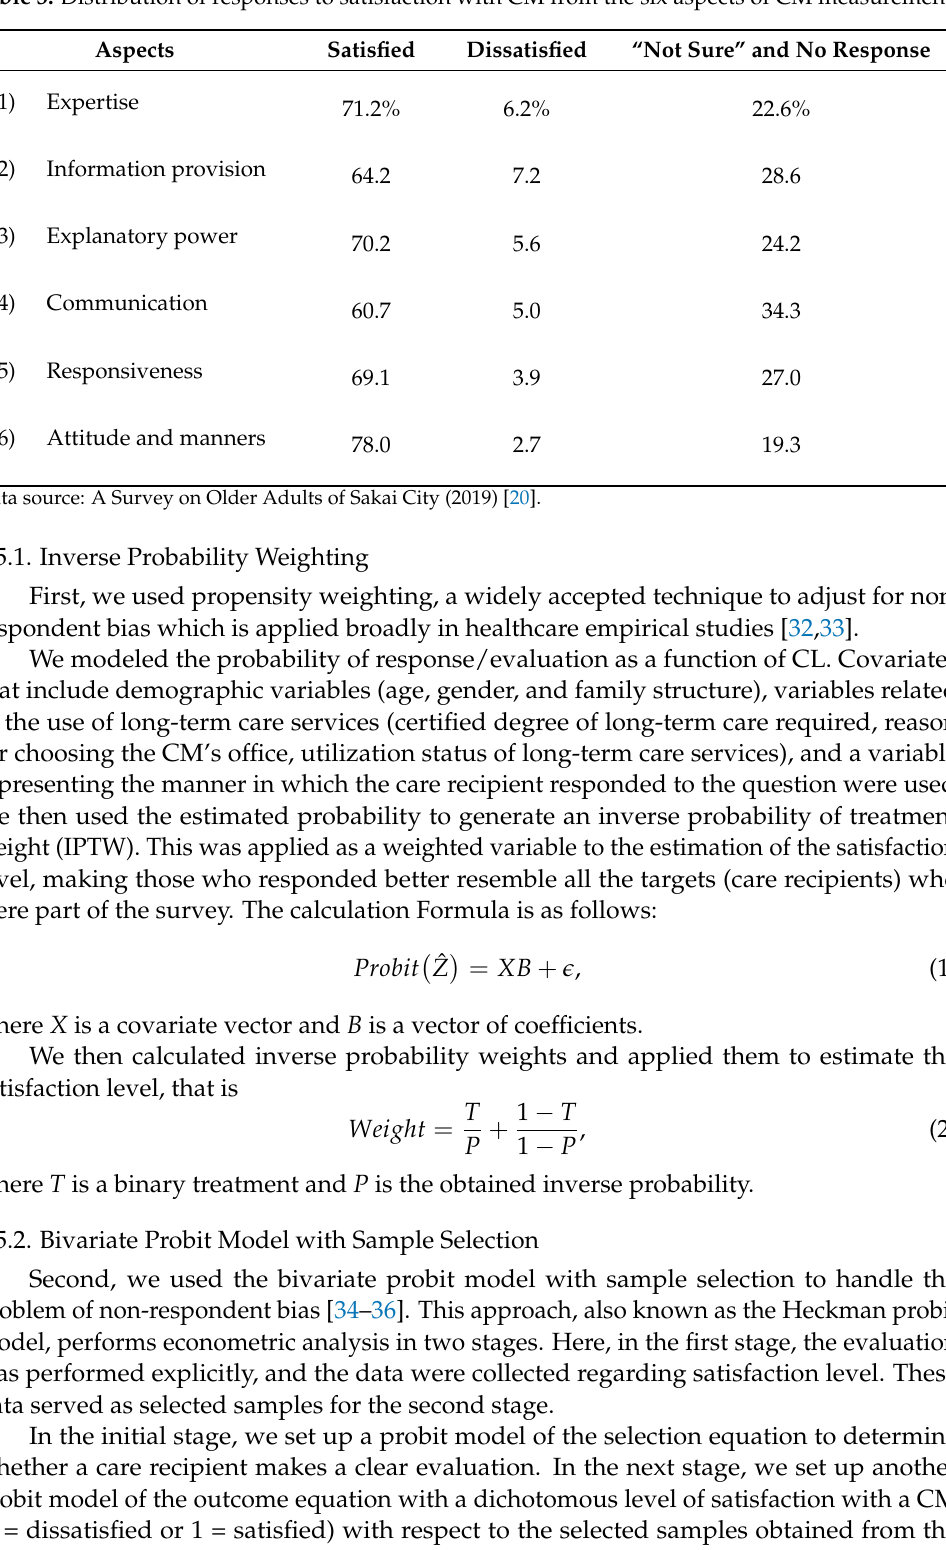
Table 3. Distribution of responses to satisfaction with CM from the six aspects of CM